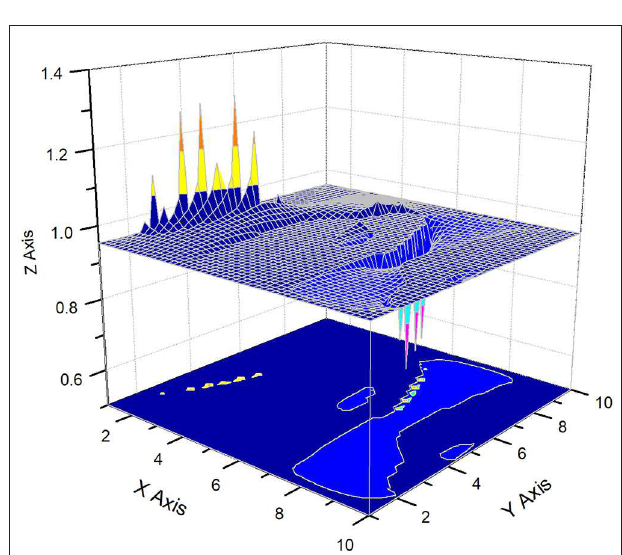
FIGURE 3 | Here we display the surface formed by the curve y 2 ( ϕ , θ ). The scale for the angles ϕ [OX axis] and θ [OY axis] is given in the numbers corresponding to the discrete data points ( j = 0,1,..10).